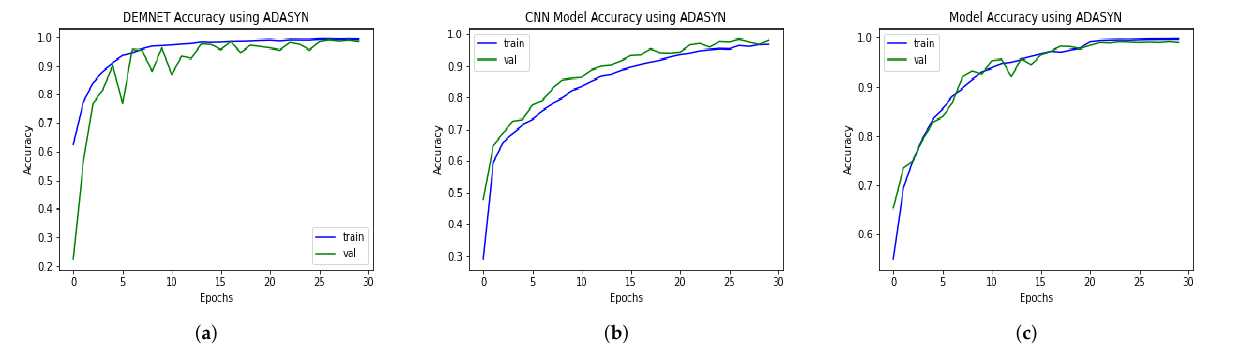
Figure 14. Accuracy Comparison of DEMNET, CNN Model, and DAD-Net using ADASYN. ( a ) DEM- NET; ( b ) CNN Model; ( c ) Proposed DAD-Net.